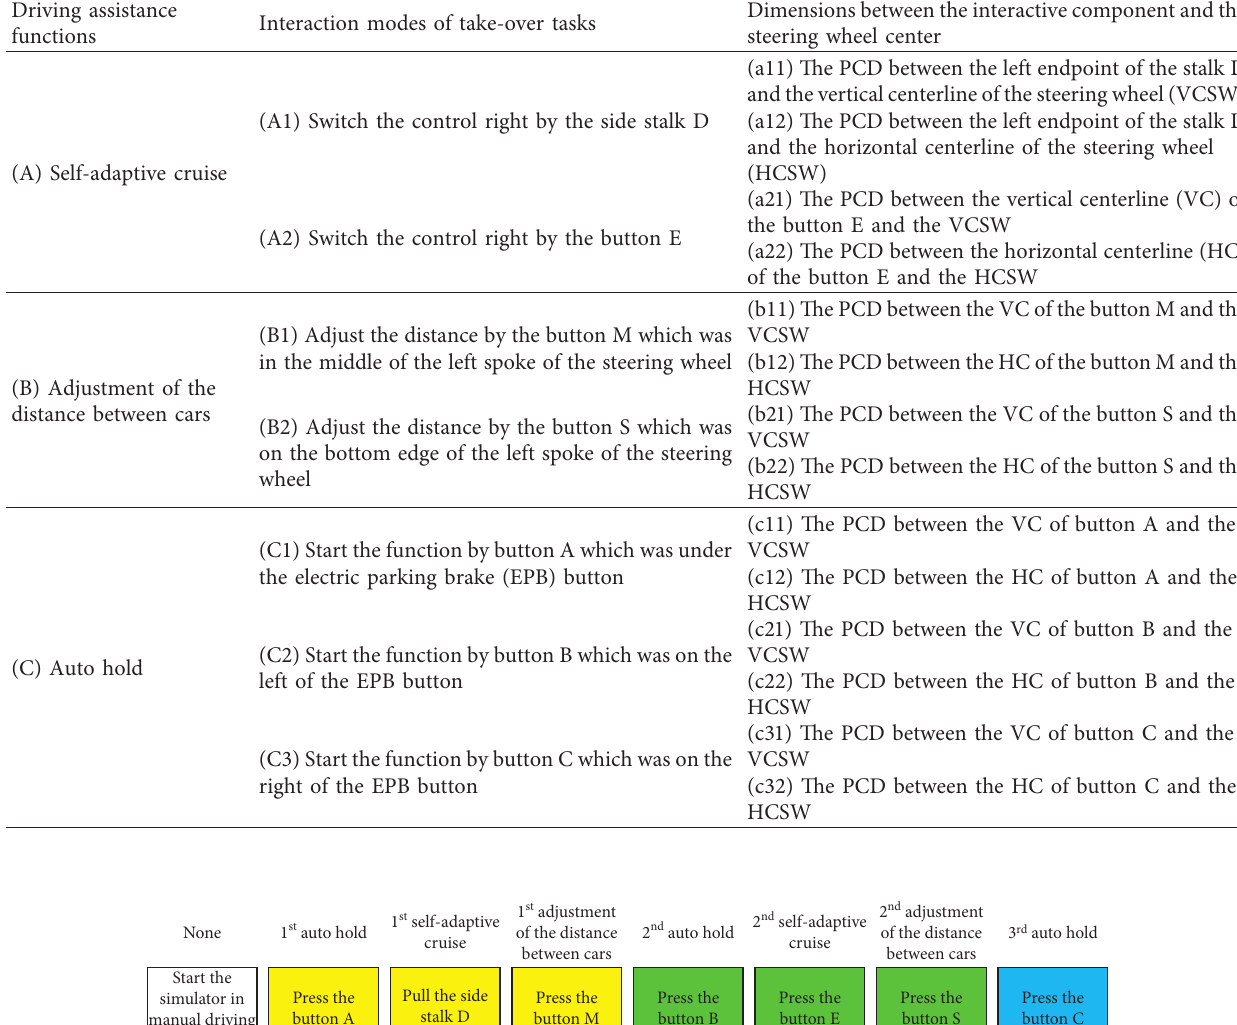
Table 1: The driving assistance functions, interaction modes, and the analyzed dimensions.